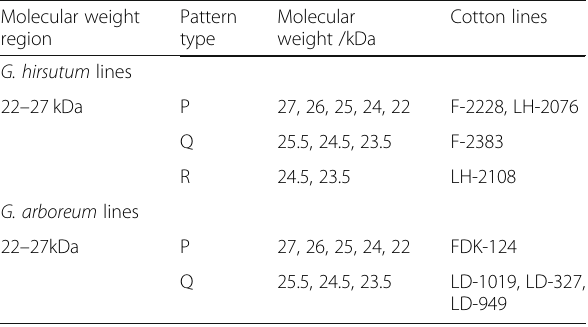
Table 6 Polypeptide pattern types in seed protein extracts of different cotton lines under reducing conditions Molecular weight region